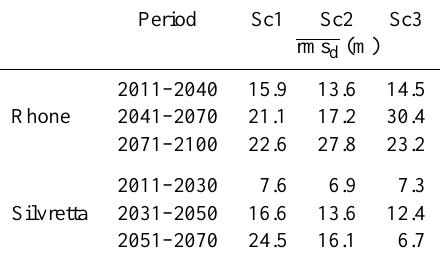
Table 2. Comparison of surface elevation calculated using the 1h -parameterization with the ice flow model for three 30-year (Rhonegletscher) and 20-year periods (Silvrettagletscher), respec- tively, and three climate scenarios (Sc1–3). rms d represents root- mean-square errors of the elevation difference at all grid cells aver- aged over the selected